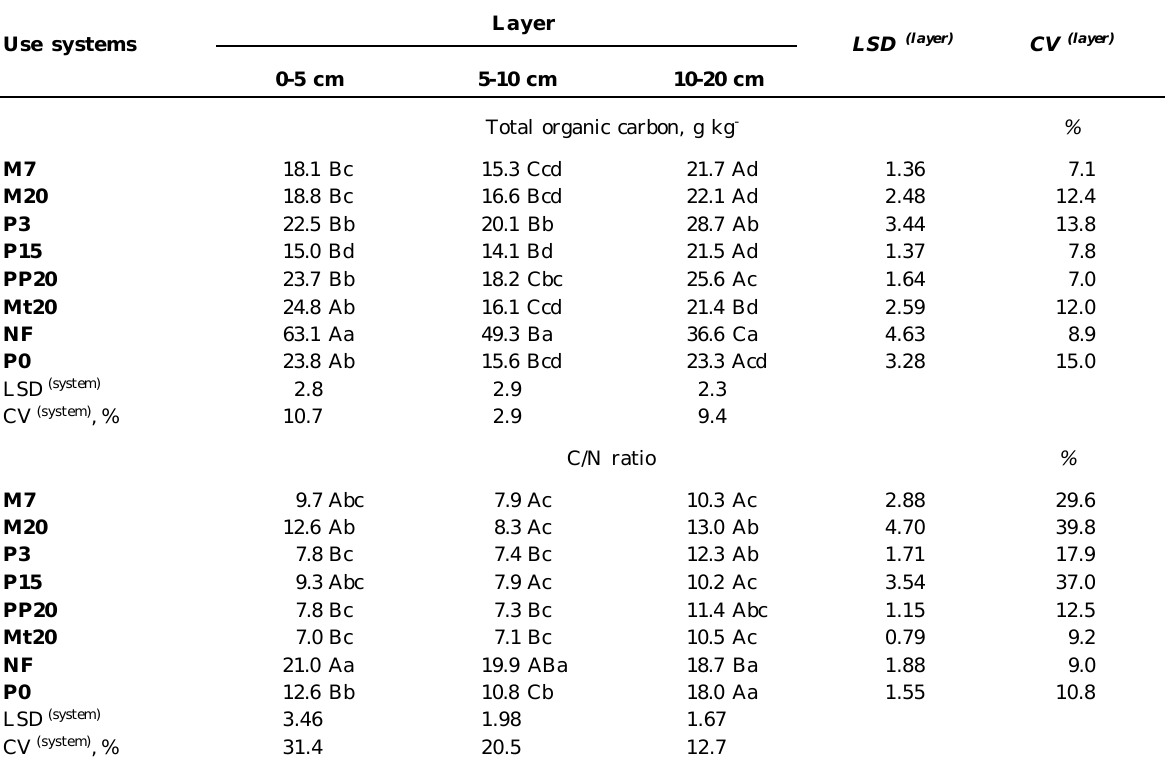
Study areas: M7: maize after 7 years of organic fertilizer application; M20: maize after 20 years of application; P3: annual pasture after 3 years of application; P15: annual pasture after 15 years of application; PP20: perennial pasture after 20 years of application; Mt20: yerba mate after 20 years of application; NF: native forest; P0: native pasture. Capital letters, in the rows, compare layers and small letters, in the columns, compare use systems, by the t test (p <0.05). LSD: least significant difference; CV: coefficient of variation.